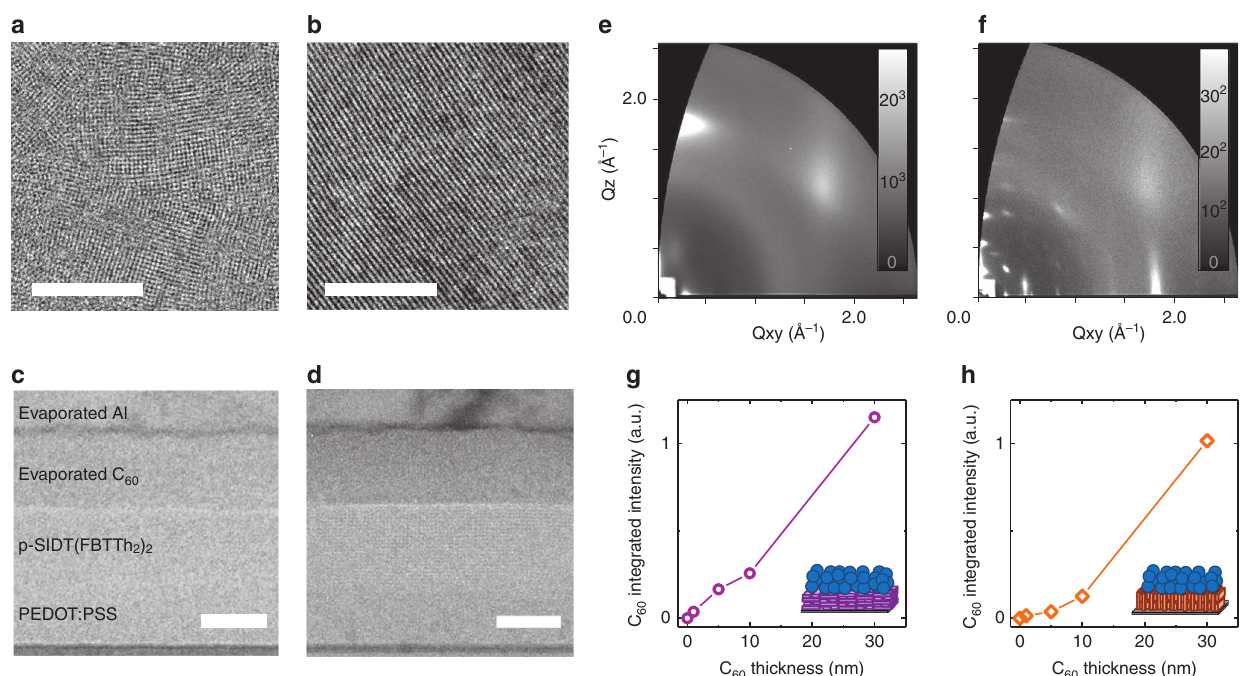
Fig. 2 Structural characterization of the molecular orientation and interface quality. HR-TEM images ( a , b ) and GIWAXS spectra ( e , f ) of face-on ( a , e ) and edge-on ( b , f ) p-SIDT(FBTTh 2 ) 2 fi lms. Cross-section HR-TEM of face-on ( c ) and edge-on ( d ) bilayers. Correlation of peak intensity fi tting with C 60 thickness evaporated on fi lms of p-SIDT(FBTTh 2 ) 2 for face - on ( g ) and edge-on ( h ) samples. For more detail, refer to Supplementary Fig. 3. Scale bar for the HR-TEM images is 50 nm; scale bar for the cross-section HR-TEM images is 40 nm